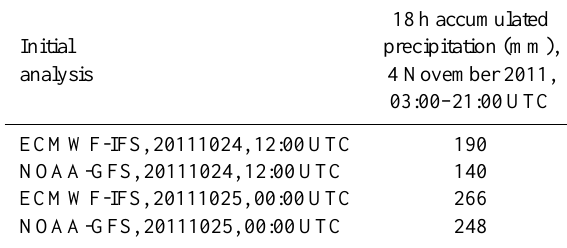
Table 2. As Table 1 but for the GE event.